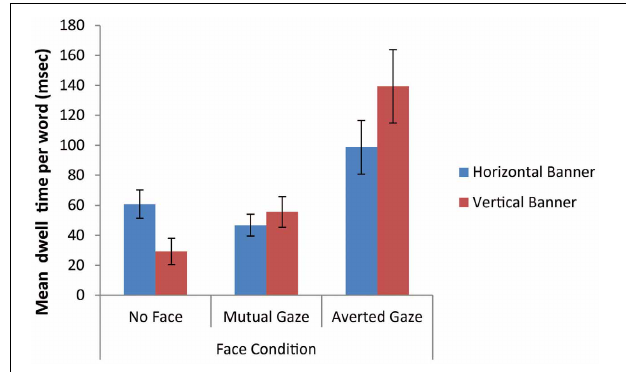
FIGURE 11 | Mean dwell time per word (milliseconds) within the advertising text ROI for vertical vs. horizontal banner advertisements as a function of face condition (error bars depict the standard error of the mean).